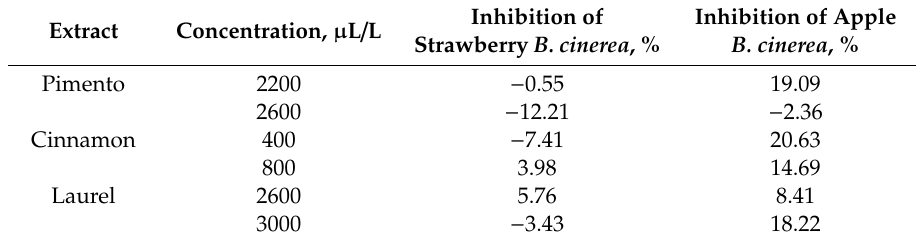
Table 1. Mycelial growth inhibition of B. cinerea on apples by different extracts compared to the control at 7 days after inoculation.